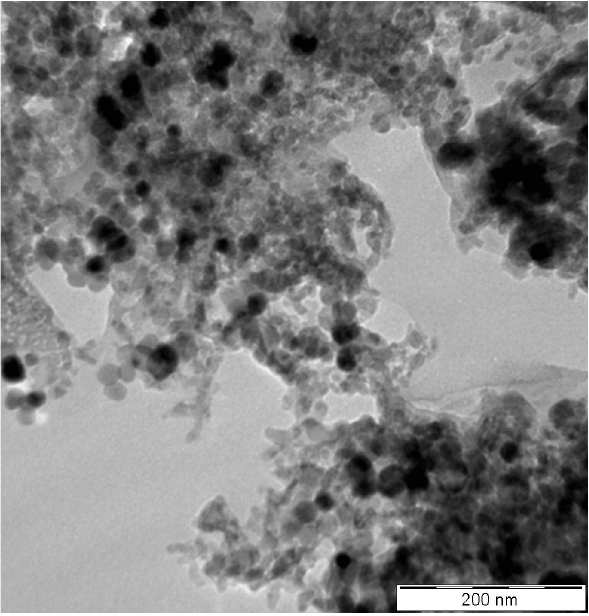
Figure 2. TEM Images of the GNP/Fe 2 O 3 hybrid nanofluid.